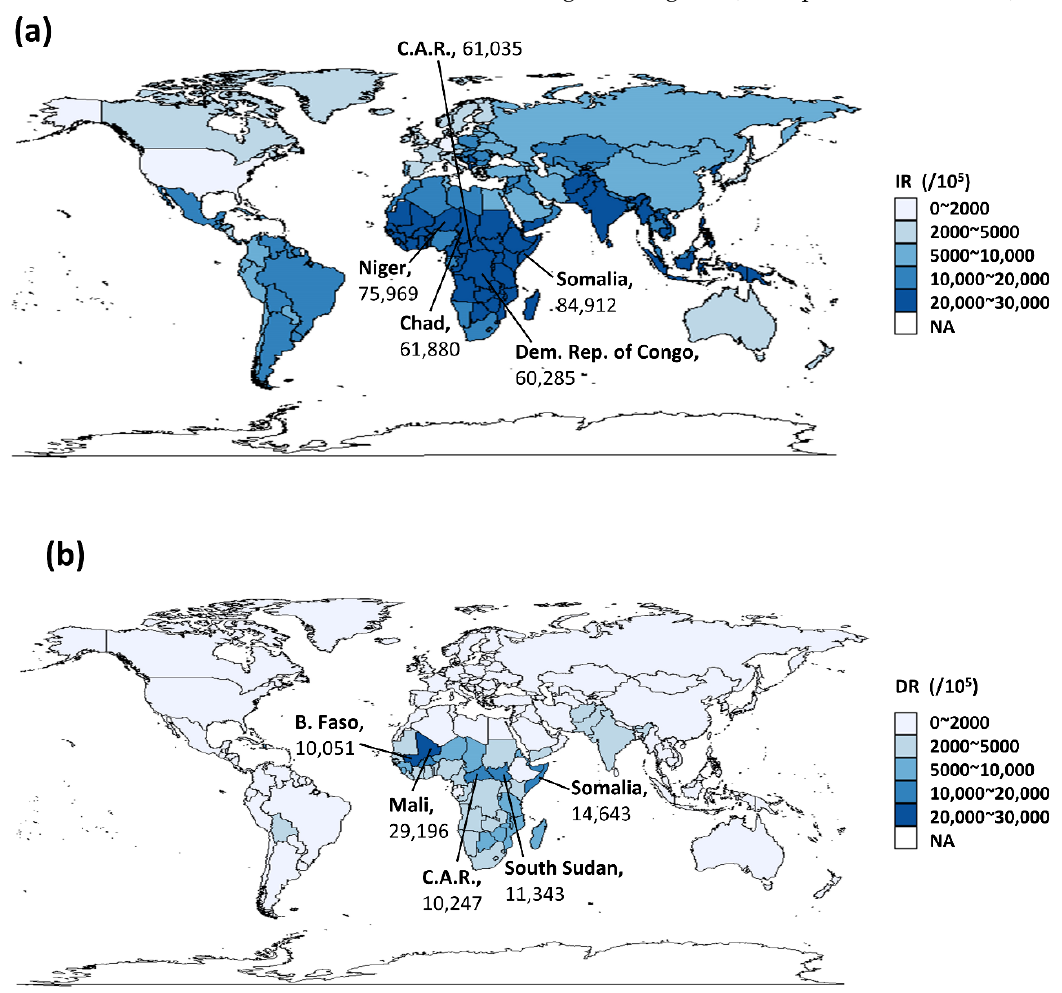
Figure 1. Global burden of nutritional deficiencies in children under 5 years of age. ( a ) Incidence rate of nutritional deficiencies in children under 5 years of age in 2019; ( b ) DALYS rate of nutritional deficiencies in children under 5 years of age in 2019. (IR: Incidence rate; DR: DALYs rate; EAPC: Estimate annual percentage change; C.A.R.: Central African Republic; Dem. Rep. of Congo: Democratic Republic of the Congo; B. Faso: Burkina Faso; and Syr.: Syrian Arab Republic) .